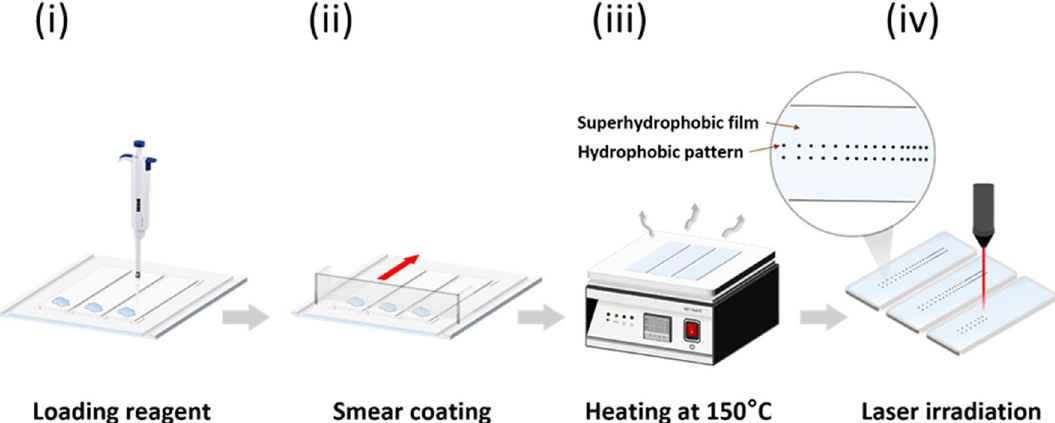
Figure 6. Fabrication of superhydrophobic film with gradient wettability patterns. (i) Loading the superhydrophobic reagent on the glass. (ii) Using the smear coating method to uniformly coat the surface. (iii) Heating the glass at 150 °C for 1 h. (iv) Lasering hydrophilic patterns on superhydrophobic surface to create wettability